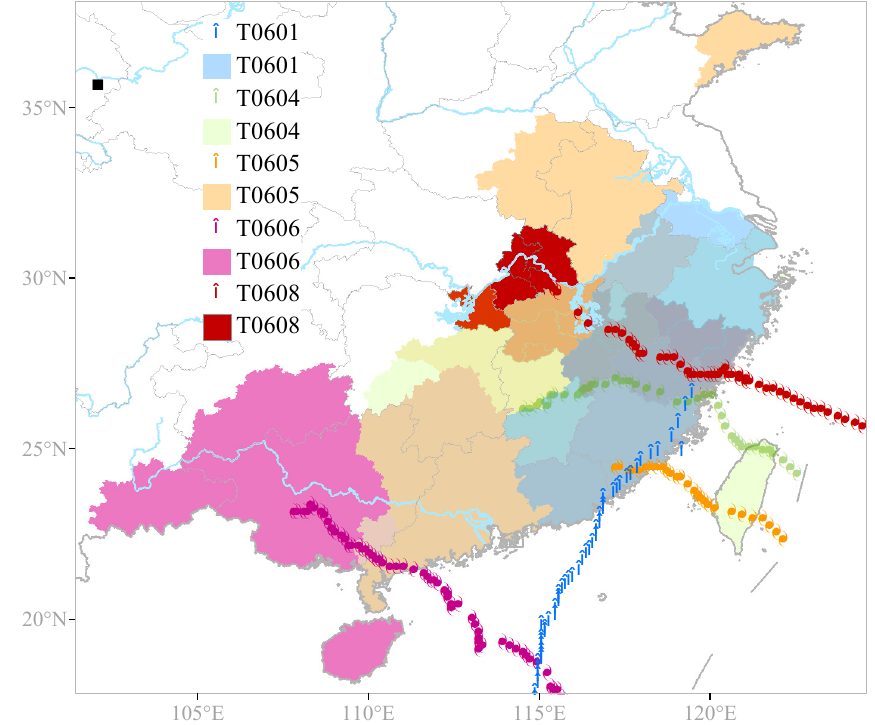
Figure 7. Affected areas and migration routes of the five major typhoons in 2006.